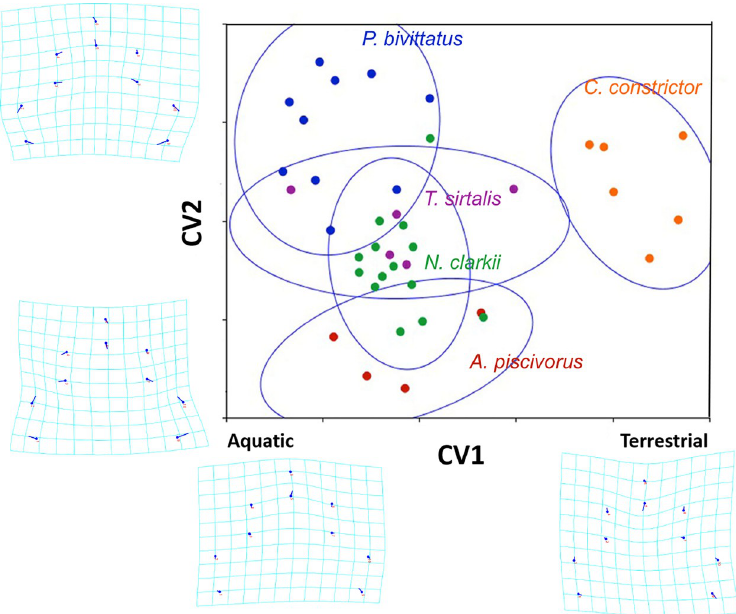
Fig 2. Canonical variance analysis plot depicting the relative separation of Raillietiella orientalis among snake hosts. Circles represent R . orientalis specimens obtained from their respective snake host ( Python bivittatus = blue; Thamnophis sirtalis = purple; Nerodia clarkii = green; Coluber constrictor = orange; Agkistrodon piscivorus = red). Axis [CV1(x)] was replaced by a perceived biological axis based on ecological variation among hosts. Confidence ellipses (95%) are shown for each centroid. Wire frame grids are shown at the ends of each axis to provide context on variation in head morphology of R . orientalis along axes.